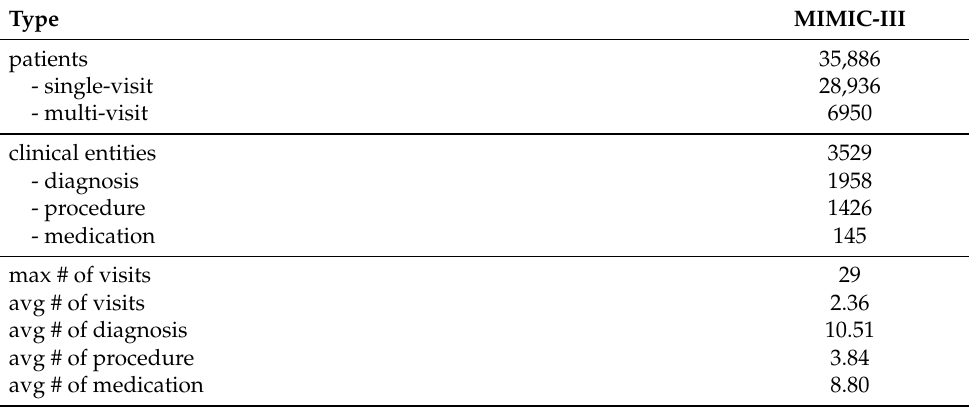
Table 3. Statistical results of MIMIC-III